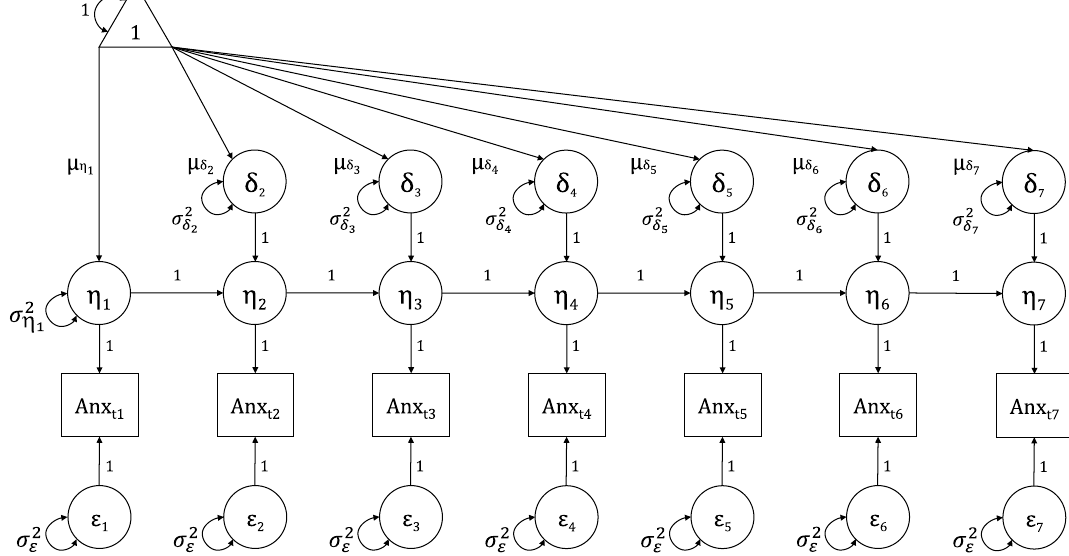
Figure 7. The unconditional latent change score (LCS) model. Error v ariances (σ 2 ) are constrained to be equal. The covariances between η t 1 and the latent change scores δη t2−t7 are omitted from the figure to aid